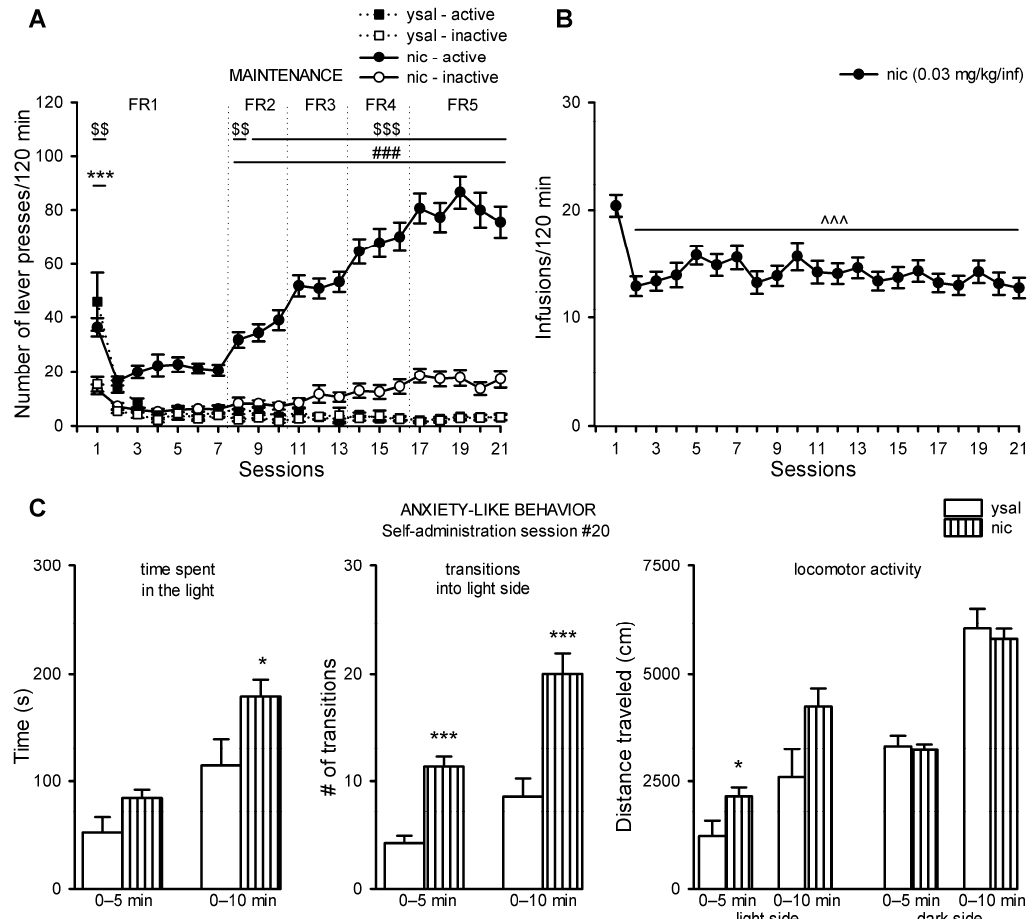
Figure 1. Nicotine self-administration and its effects on anxiety-like behavior in rats. ( A ) The number of lever presses in rats self-administering nicotine (0.03 mg/kg/inf; nic) and rats that received saline (ysal) during an increasing schedule of reinforcement (fixed ratio (FR)1-5). ( B ) Nic intake throughout 21 self-administration sessions. ( C ) Effects of nicotine self-administration on anxiety-like behavior in the light/dark box test (LDB). The data are expressed as the means (± SEM). ysal: n = 12; nic: n = 30. ( A ) *** p < 0.001 versus ysal-inactive; $$ p < 0.01, $$$ p < 0.001 versus nic-inactive; ### p < 0.001 versus ysal-active; ( B ) ^^^ p < 0.001 versus session 1; ( C ) * p < 0.05, *** p < 0.001 versus ysal.